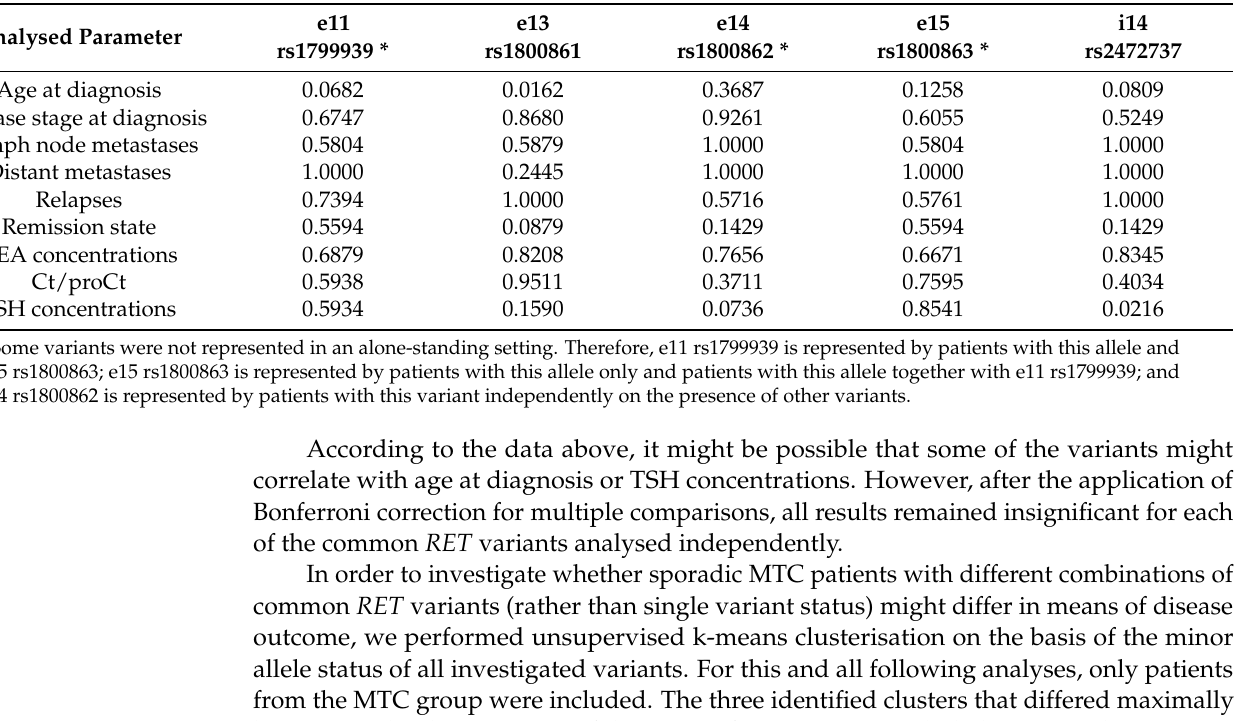
Table 3. Comparison of clinical parameters between given variant carriers and sporadic MTC patients with no RET variant in the analysed regions. p -values for each analysis are